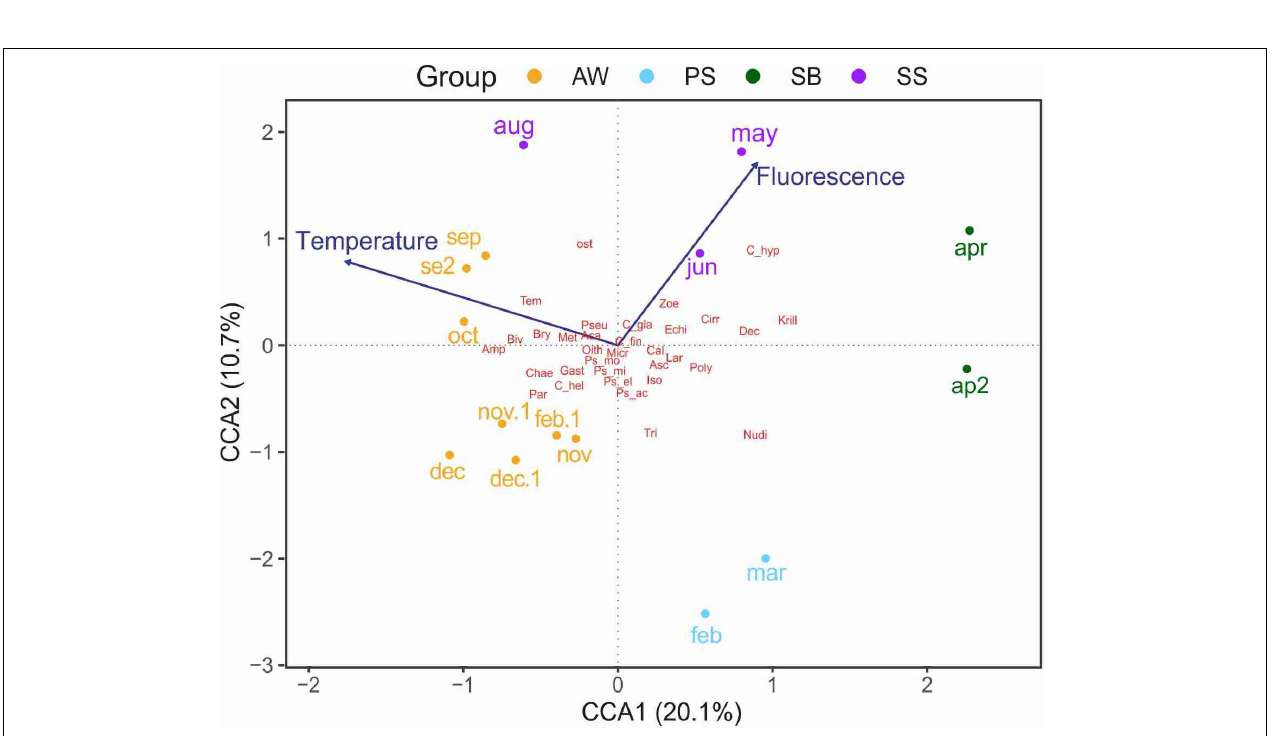
FIGURE 6 | Seasonal changes in Calanus spp. Abundance (A) , stage composition (B) , and species composition (based on metabarcoding) (C) in Ramfjord November 2018–February 2020.